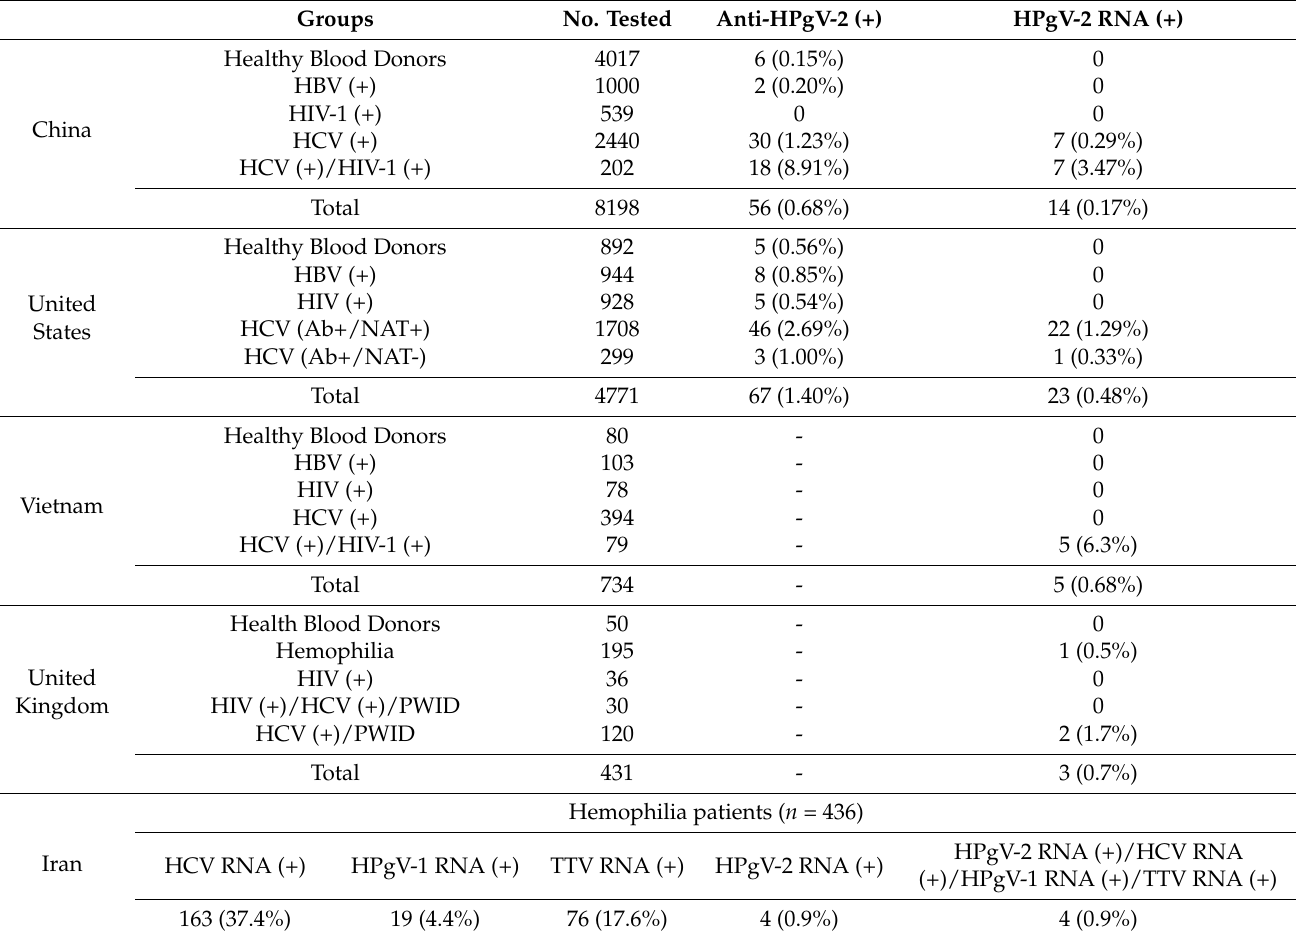
Table 1. Serologic and molecular detection of HPgV-2 in different populations.